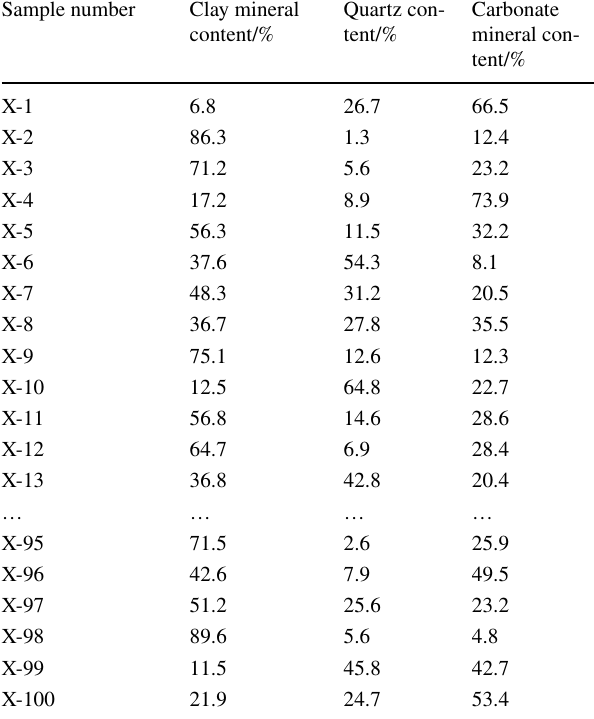
Table 3 The mineral composition of samples Sample